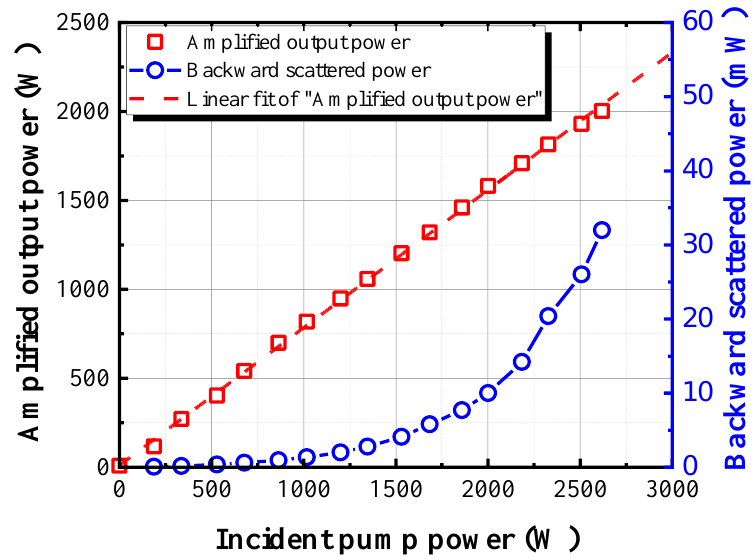
Figure 3. The measured amplified output power (red) and backward scattered power (blue) as a function of incident pump power.